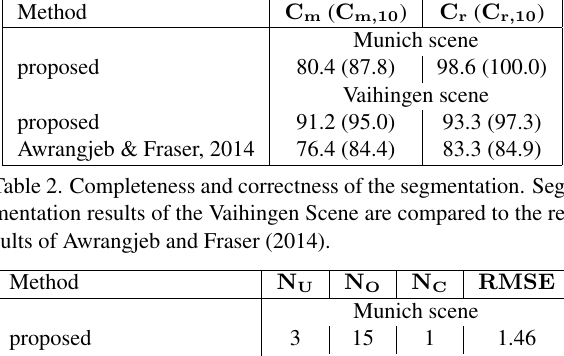
Table 5. Under- and over-segmentation and accuracy of the re- construction. Results of the Vaihingen Scene are compared to the results of other methods (* see Rottensteiner et al.,